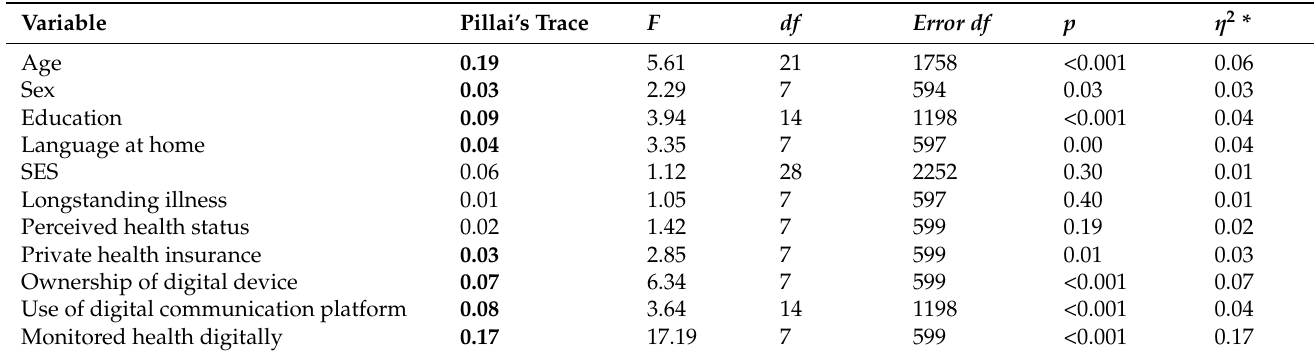
Table 3. Relationship between sociodemographic variables and the combination of the seven eHLQ